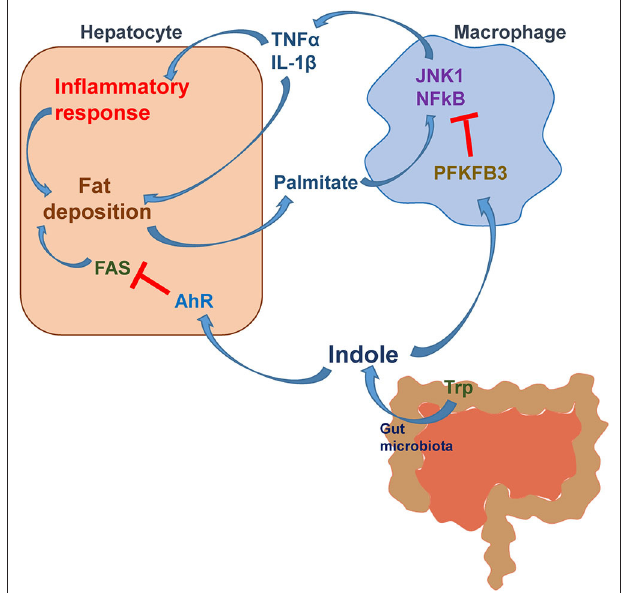
FIGURE 2 | The mechanistic scheme for indole alleviation of NAFLD. During NAFLD, hepatocytes release fat deposition-associated proinflammatory mediators and palmitate (hydrolysis product of very low-density lipoproteins), which act on macrophages to enhance the proinflammatory responses. Active macrophages release proinflammatory factors such as TNF α and IL-1 β and act, via paracrine manners, to exacerbate the proinflammatory responses and fat accumulation in hepatocytes. Indole, a microbiota metabolite from tryptophan (Trp), acts to reduce hepatocyte fat deposition via suppressing the expression of FAS through a mechanism involving AhR activation. Moreover, indole reduces the inflammatory responses in both macrophages and hepatocytes and fat deposition in hepatocytes in a manner involving myeloid cell PFKFB3. Modified based on Krishnan, S., et al. Cell Reports, 2018. 23(4): p. 1099-1111 and Zheng et al. Front Med 2015; 9: 173-186